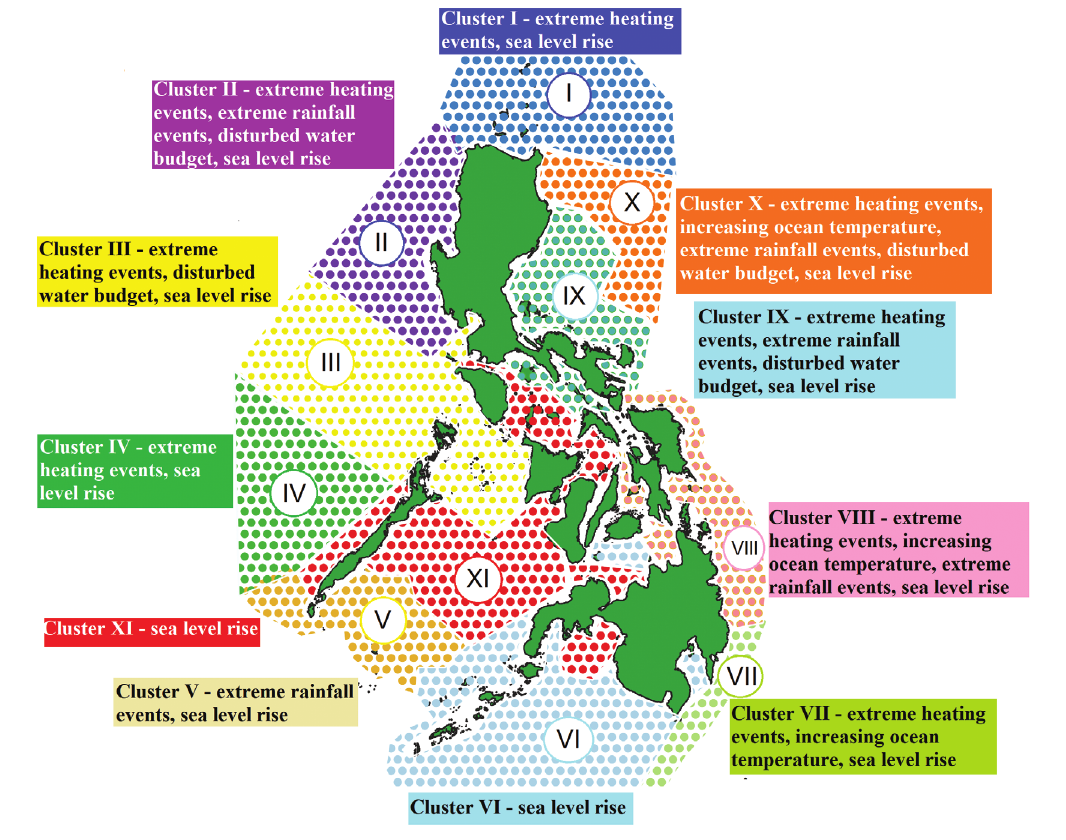
Philippine Exposure map on Climate Change (Source: Department of Environment and Natural Resources, Philippines,